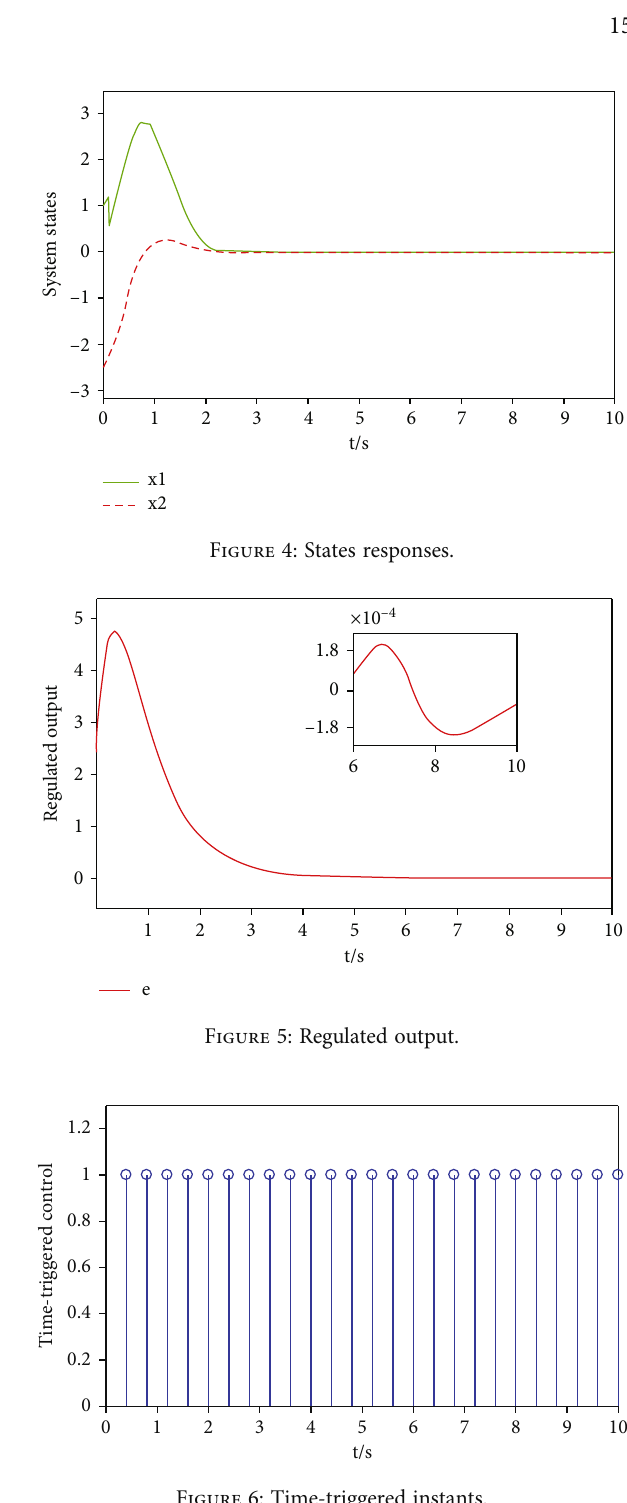
Figure 6: Time-triggered